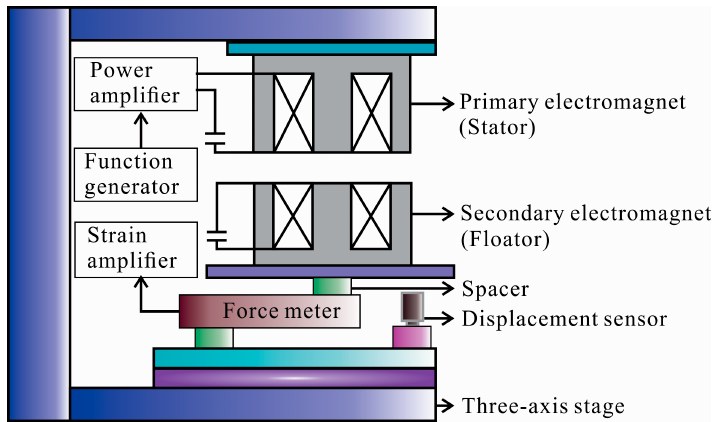
Figure 6. Schematic diagram of the experimental apparatus for investigating fundamental characteristics.